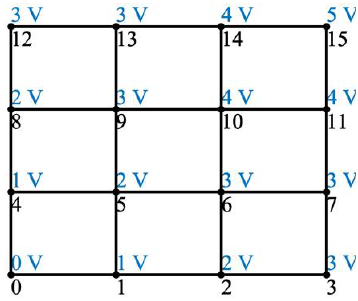
Figure 13. Node voltage solutions for 4 × 4 lattice converter shown in Figure 10.